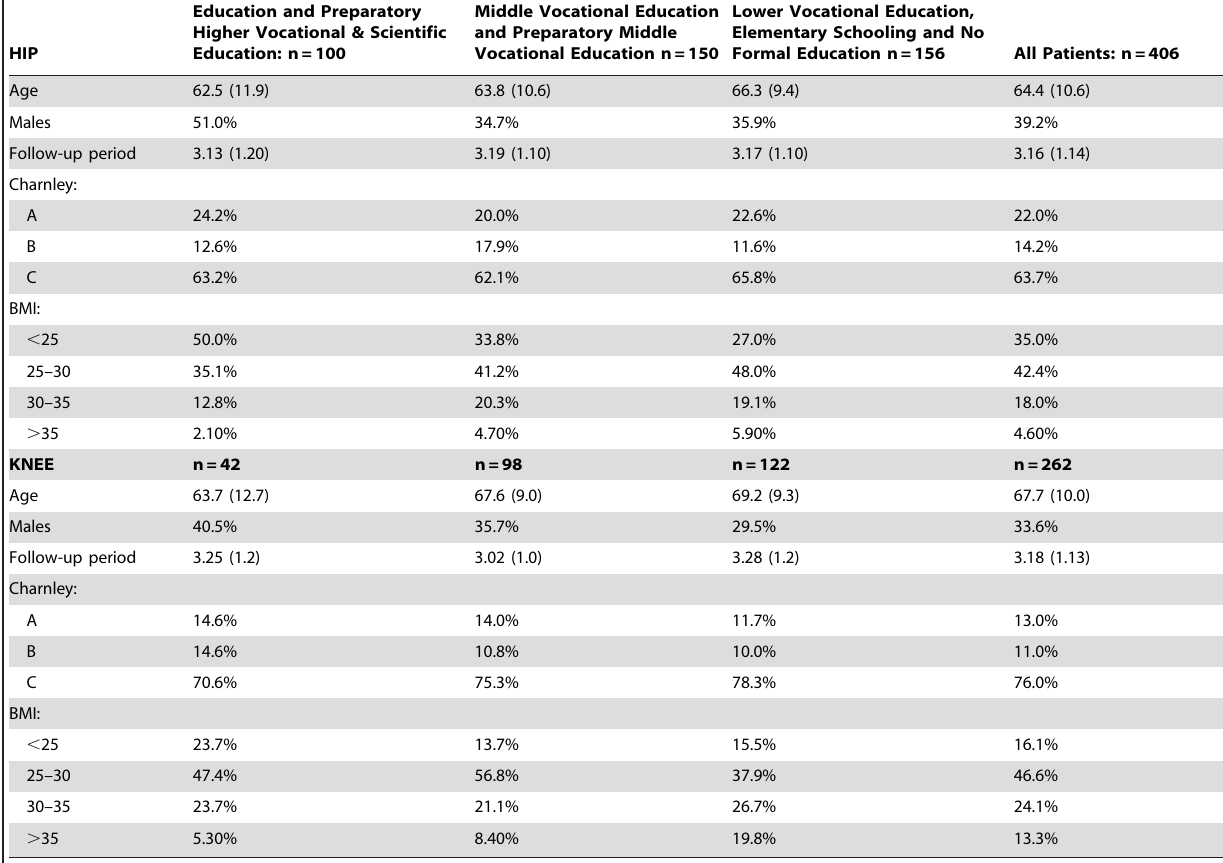
Table 1. Patient Characteristics.